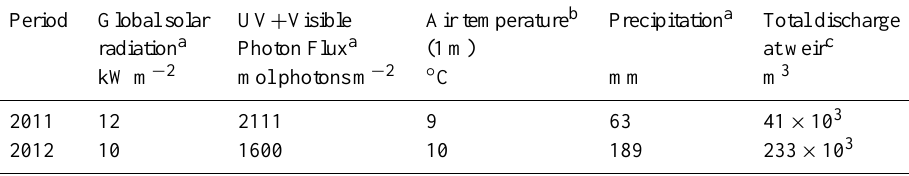
Table 1. Meteorological conditions at Toolik Field Station during study periods.